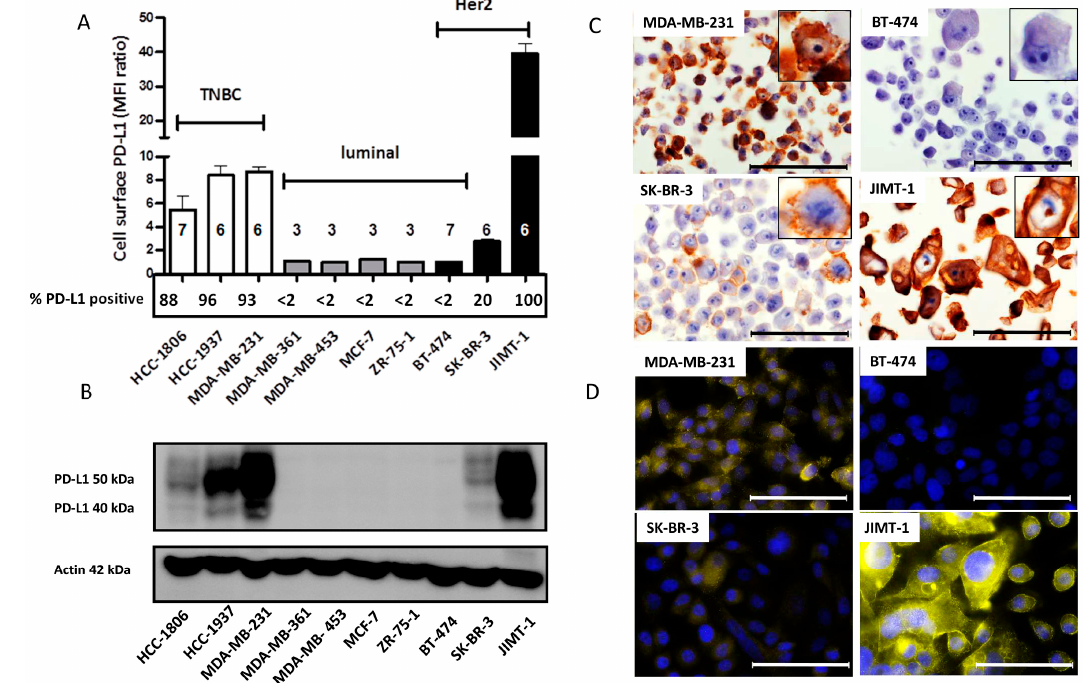
Figure 1. Programmed death ligand 1 (PD-L1) expression on different breast cancer (BC) cell lines. ( A ) Triple-negative breast cancer (TNBC), luminal and Her2 overexpressing BC cell lines were analyzed on basal PD-L1 cell surface expression by flow cytometry (mean fluorescence intensity (MFI) ratio = (MFI PD-L1 /MFI isotype ) ± standard error of the mean (SEM)). Numbers of analyzed experiments are indicated above each cell line. Flow cytometric data of % PD-L1 positive cells are presented below each bar for each cell line; ( B ) PD-L1 protein expression was evaluated by western blot analysis. Actin was used as loading control; ( C ) Immunochemical staining of PD-L1 was performed on FFPE embedded BC cell lines. Bars represent 100 µm; ( D ) Immunofluorescence staining of PD-L1 on four representative BC cell lines. Bars represent 100 µm.